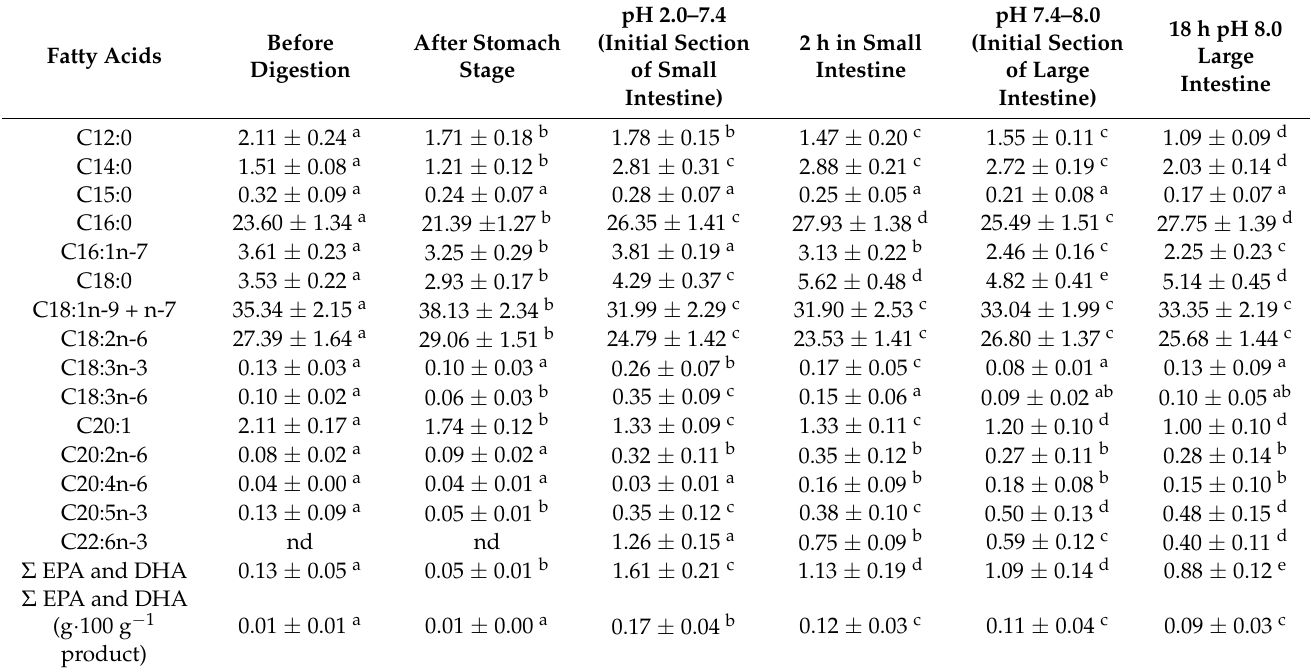
Table 5. The fatty acid profile of the sausage with the microencapsulated oil additive subjected to in vitro